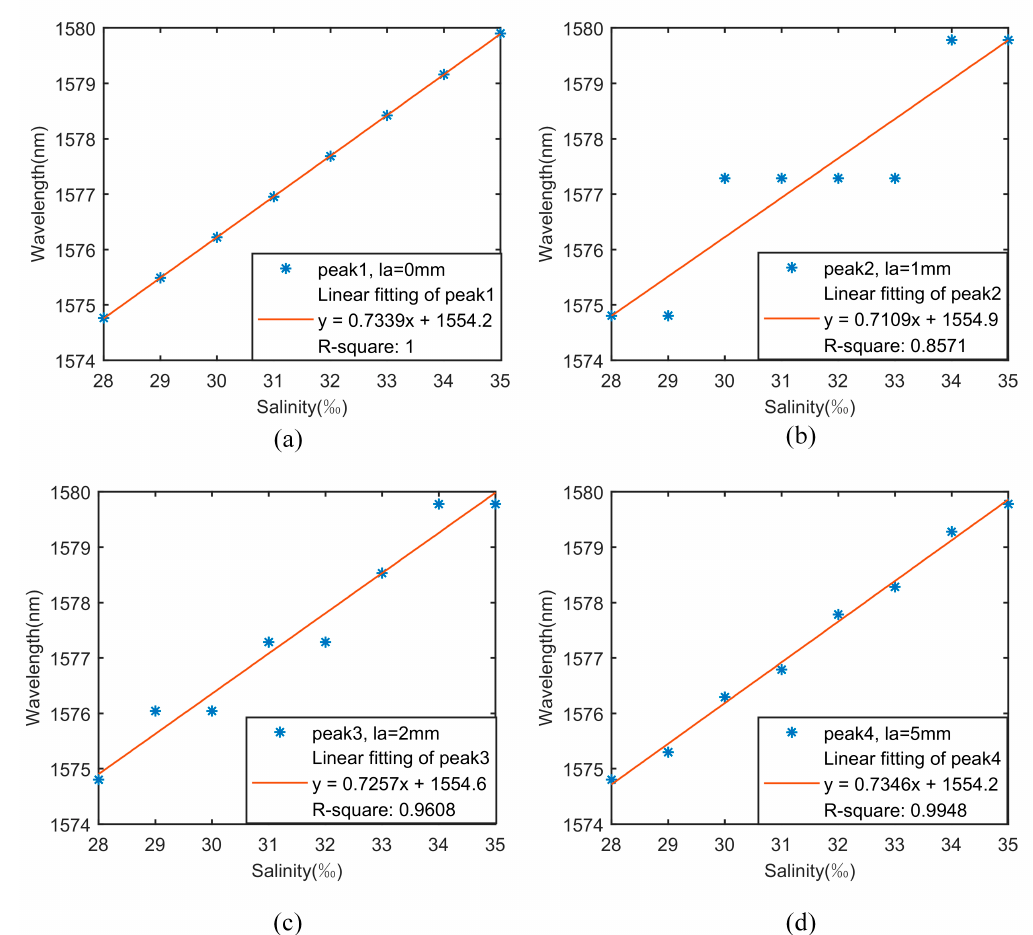
Figure 4. The fitting lines of interference peak wavelength shift with salinities under the arm difference ( a ) l a = 0 mm, ( b ) l a = 1 mm, ( c ) l a = 2 mm, and ( d ) l a = 5 mm.